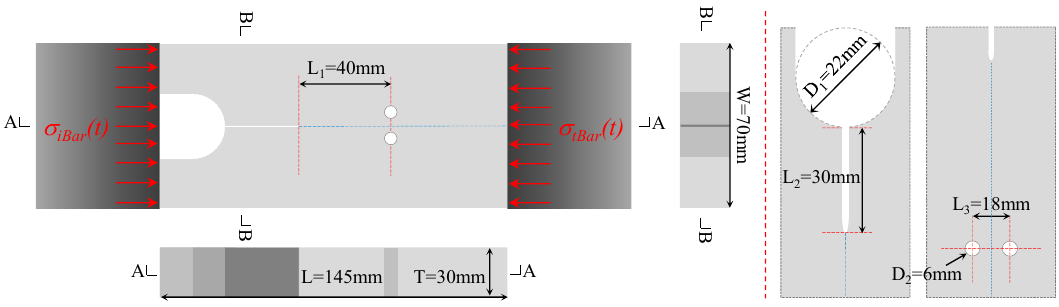
Figure 3. Improved Single Cleavage Semi-Circle Specimen (ISCSC) specimen sample geometry.